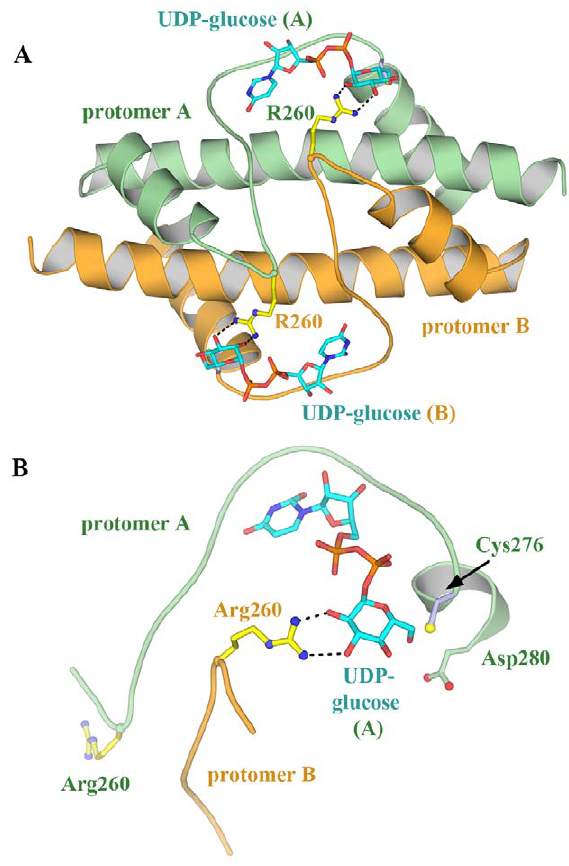
Figure 4. Cooperativity within the hUGDH dimeric unit. (A) Residues 265–280 wrap around and orient UDP-glucose in one subunit while Arg260 forms two hydrogen bonds to the glucose moiety of UDP- glucose in the second protomer. Hence, residues 260–280, which include active site residues Cys276 and Asp280, may act as a sensor by transmitting the state of one UDP-glucose binding site to the other protomer at the dimer interface. (B) Close up of the UDP-glucose binding